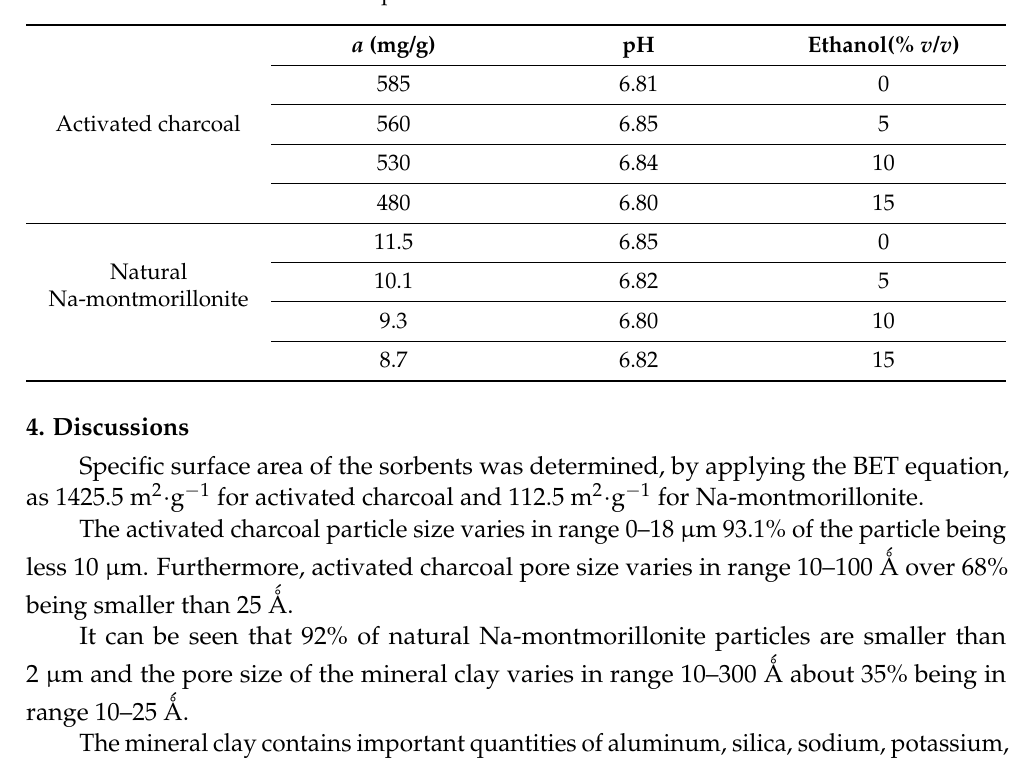
Table 9. Maximum amount of diazepam adsorbed from SIF with and without ethanol.